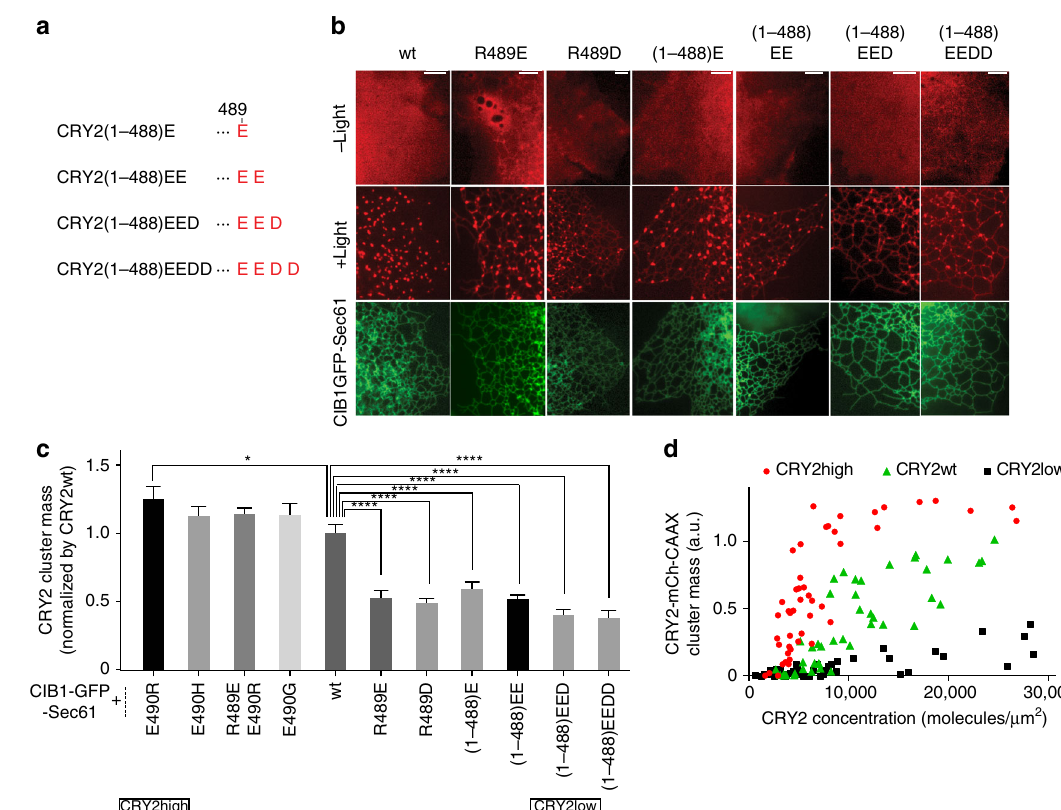
Fig. 3 Negative charges at the C-terminus of CRY2 inhibit CRY2 homo-oligomerization. COS7 cells were co-transfected with CIB1-GFP-Sec61 and each mCh-tagged CRY2, respectively. Blue light of 200-ms duration was delivered at 2-s intervals for 20 s ( a – c ) or one 100-ms pulse of blue light was delivered ( d ). a Increasing numbers of negative charges were introduced to the C-terminus of CRY2(1 – 488). b After recruitment to the ER membrane via CRY2 – CIB1 hetero-dimerization, CRY2 derivatives with more C-terminal negative charges formed fewer clusters as compared to CRY2wt. c The cluster mass of each CRY2 mutant on ER membrane was separately quanti fi ed and then normalized to that of CRY2wt. Results are presented as means ± s.e.m. ( n = 13, 12, 15, 14, 16, 12, 11, 13, 11, 15, 12) and analyzed using one-way ANOVA with Dunnett ’ s post hoc test. (* P < 0.05, **** P = 0.0001). d CRY2high, CRY2wt and CRY2low formed different amount of clusters on plasma membrane at different CRY2 concentrations. (CRY2high n = 48, CRY2wt n = 48, CRY2low n = 49) Scale bars , 5 µ